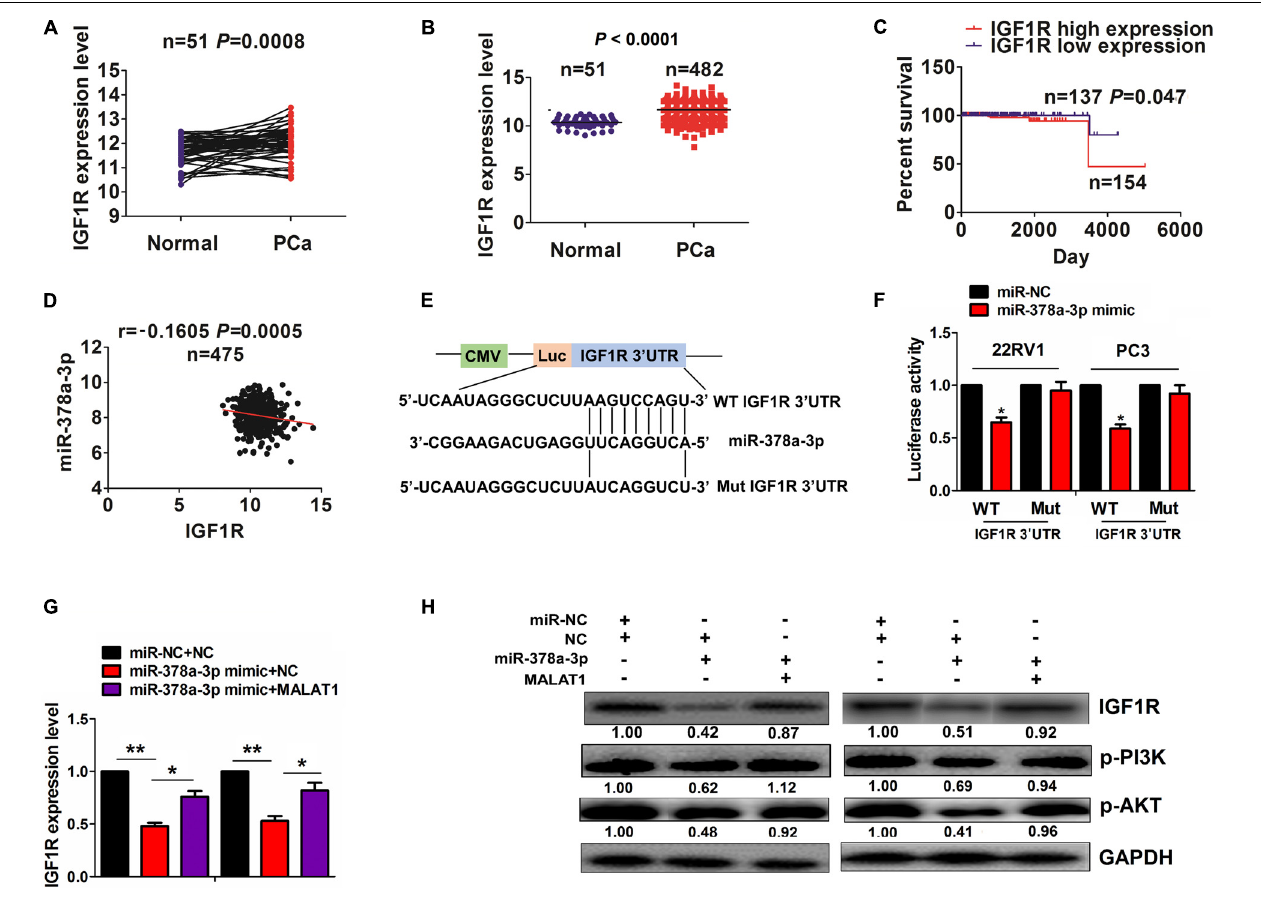
FIGURE 6 | miR-378a-3p reversed circPDHX-induced insulin-like growth factor 1 receptor (IGF1R) expression in prostate cancer (PCa) cells. (A,B) The Cancer Genome Atlas (TCGA) analysis of the expression levels of IGF1R in paired ( n = 51) and unpaired PCa tissue samples ( n = 482). (C) Kaplan–Meier analysis of the association of high or low IGF1R expression with poor survival in patients with PCa. (D) Pearson correlation analysis of the correlation of IGF1R with miR-378a-3p expression in PCa tissues. (E) Schematic representation of the binding sites of miR-378a-3p and WT or Mut 3 (cid:48) untranslated region (UTR) of IGF1R. (F) Estimation of the luciferase activities of WT or Mut IGF1R 3 (cid:48) UTR after cotransfection with miR-378a-3p mimic and WT or Mut IGF1R 3 (cid:48) UTR reporter vectors in 22RV1 and PC3 cells. (G,H) Quantitative real-time PCR (qRT-PCR) and Western blot analysis of IGF1R expression levels after cotransfection with circPDHX and miR-378a-3p mimic in 22RV1 and PC3 cells. Data shown are the mean ± SEM of three experiments. * P < 0.05; ** P <